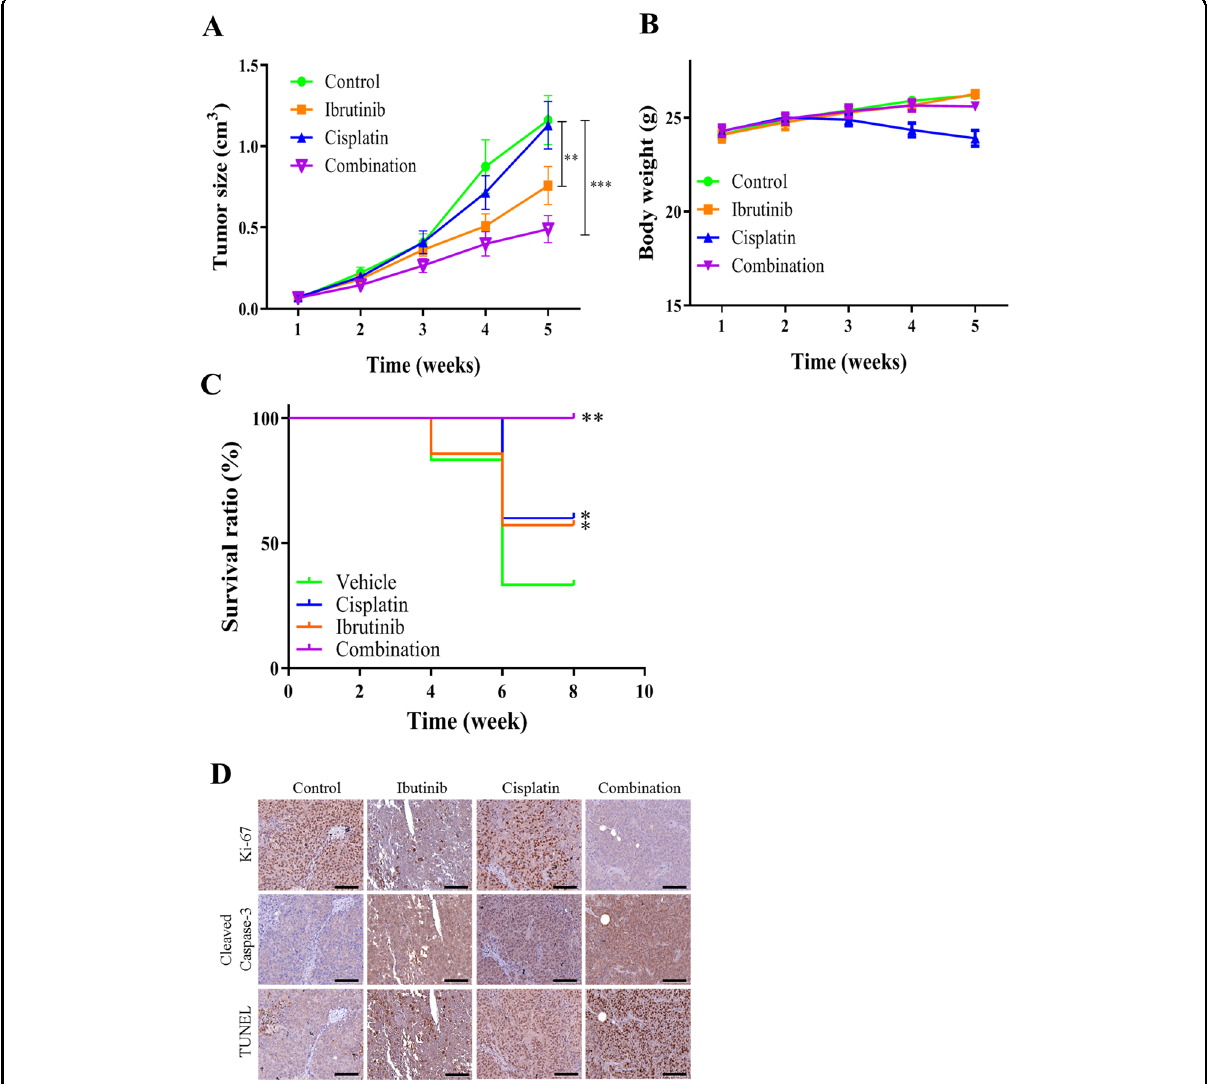
Fig. 6 Ibrutinib improve the cisplatin-resistant SAS CSCs in vivo. A Photographs of oral cancer cells, SAS-IR (1 × 10 6 cells/injection, subcutaneous) were injected into the NOD/SCID (NOD.CB17- Prkdc scid /NcrCrl) mice for establishing the tumor xenograft model ( n = 5 per group). When tumor size became palpable, mice were separated into four groups: vehicle control, ibrutinib (10 mg/kg, i.p., 5 times a week), cisplatin (5 mg/kg, i.p., once a week), and ibrutinib + cisplatin. B Tumor volume versus time effect curve. Ibrutinib + cisplatin treatment displayed the most signi fi cant decrease in tumor volume followed by ibrutinib-only treatment, whereas cisplatin only and vehicle treatments displayed the largest tumor volume. C Kaplan – Meier survival curve. Mice receiving the ibrutinib + cisplatin regimen exhibited the highest survival ratio followed by the ibrutinib only group, whereas the cisplatin only and vehicle groups exhibited the lowest survival ratios. D IHC image of of the xenograft tumors revealed that the ibrutinib/ cisplatin combination effectively inhibited the expression of Ki-67 and induction of cleaved capase-3. * p < 0.05; ** p < 0.01; *** p < 0.001. Scale bar: 100 μ